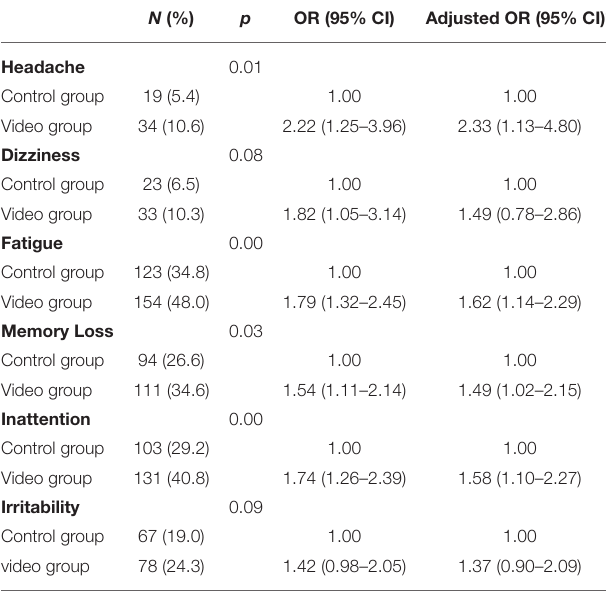
TABLE 3 | Association between watching video and physical symptoms ( n = 674).